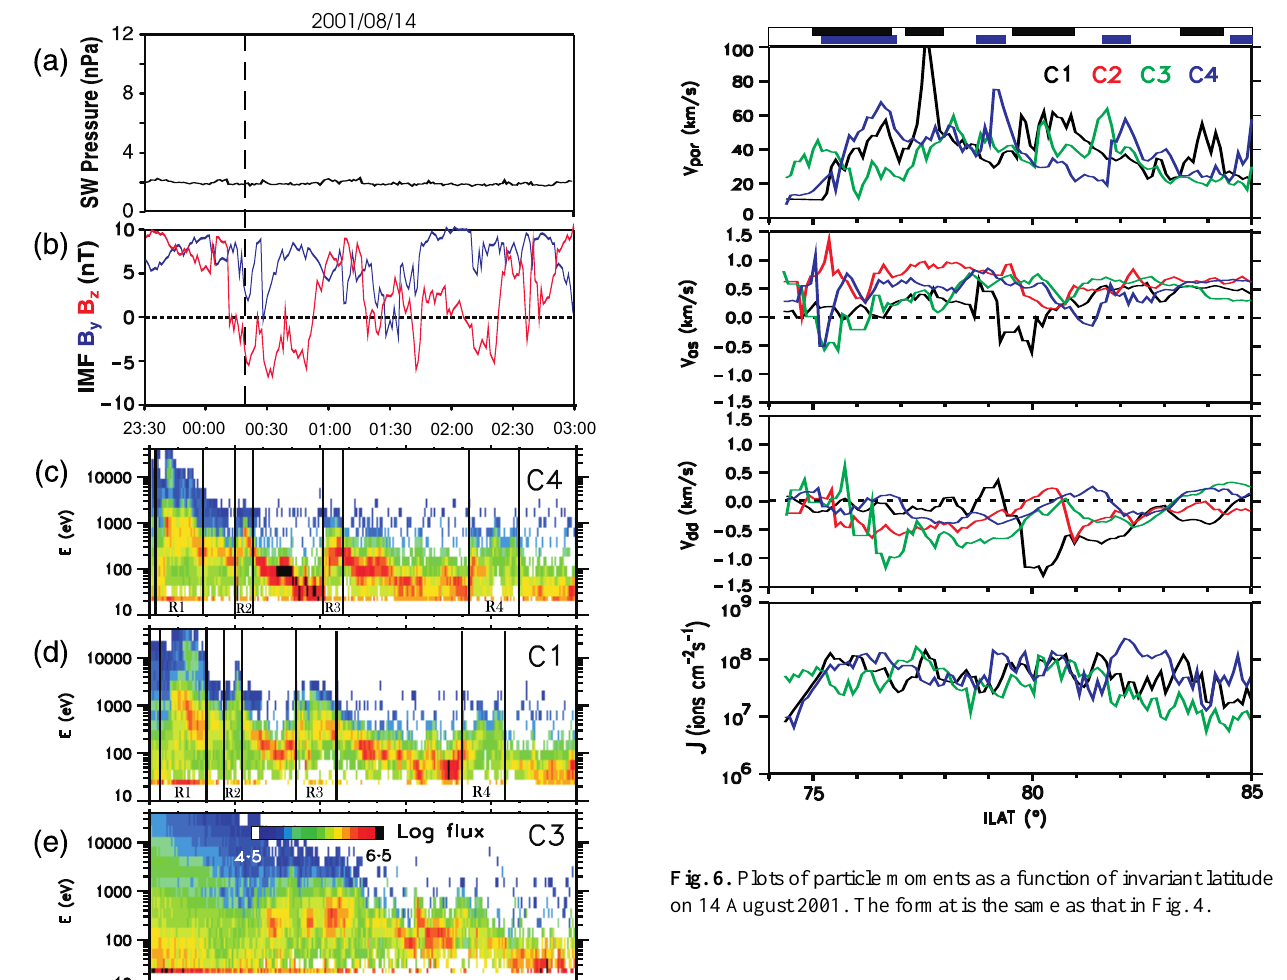
Table 2. List of rank correlation coefficients of invariant latitude series of upward velocity, convection drift and upward integral flux between C1 and C4, and between C1 and C3, on 14 August 2001. The last row indicates the corresponding flux